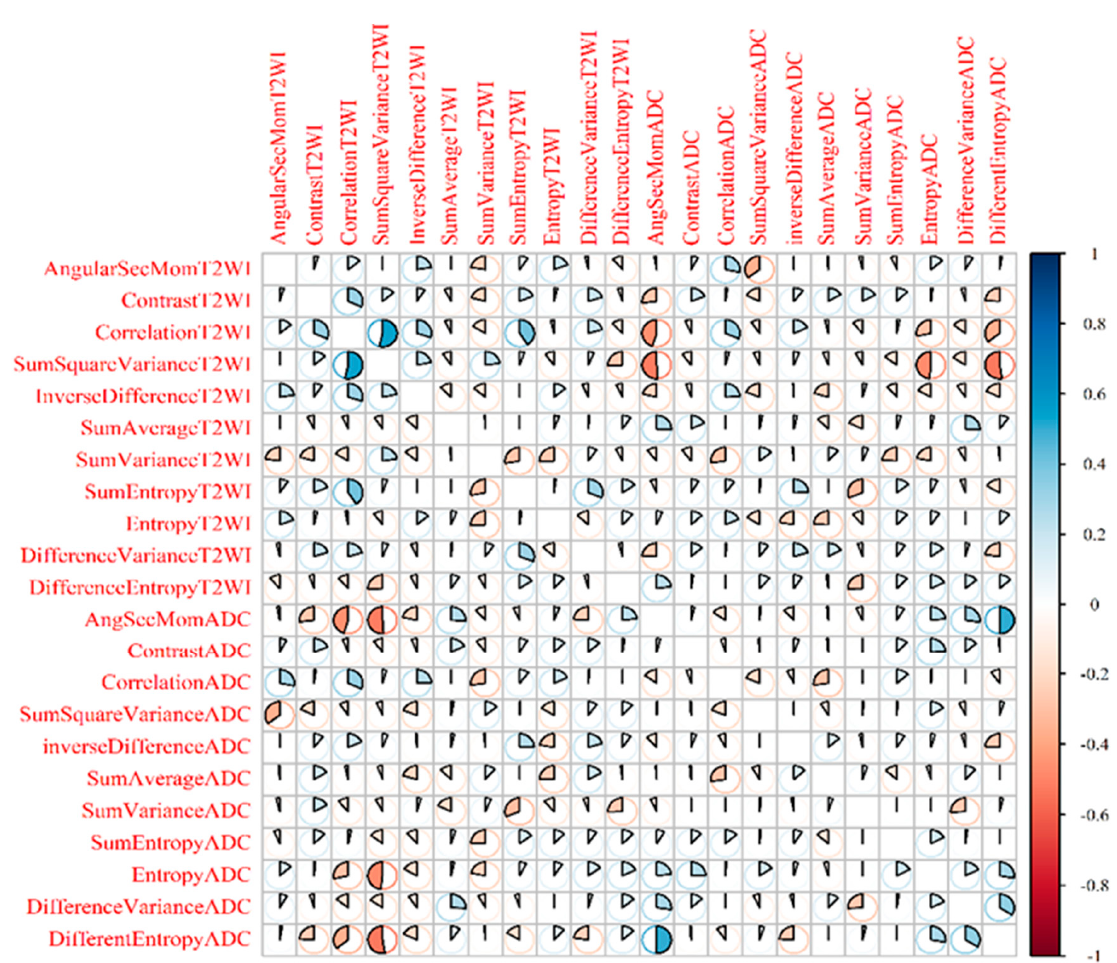
Figure 2. Heatmap of the Kruskal–Wallis (after applying the Holm–Bonferroni correction) significant test p -values using radiomics features to identify patients of different GS. Significant features that were compared with the GS groups are shown in the colour black (corrected p -value < 0.05).